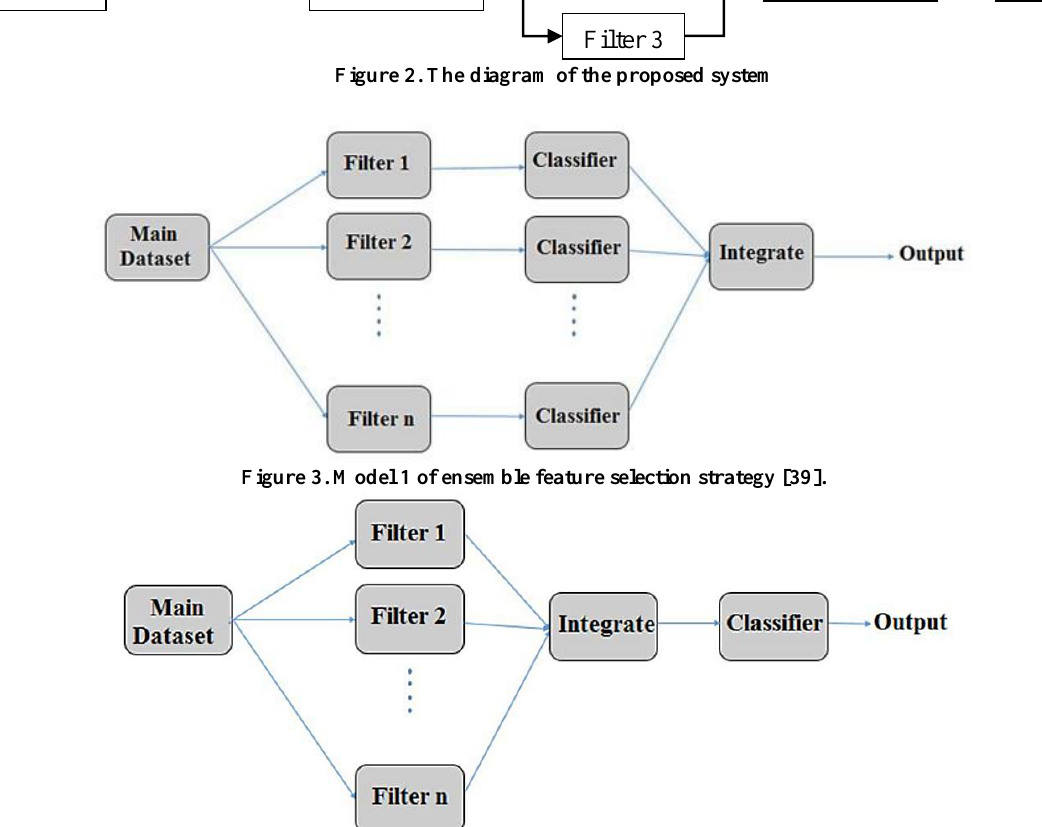
Figure 4. Model 2 of ensemble feature selection strategy